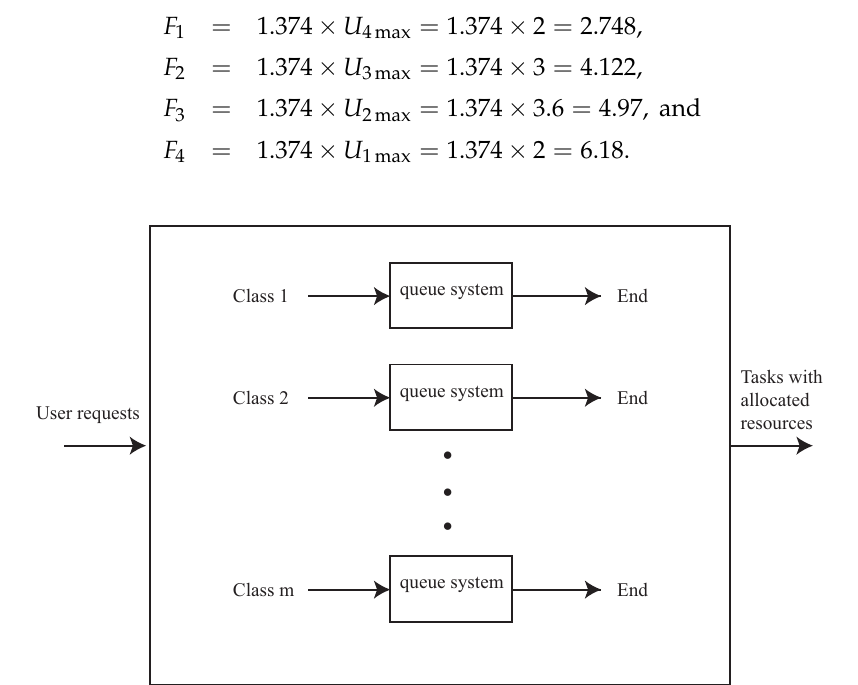
Figure 2. Resource Allocator with m Queue